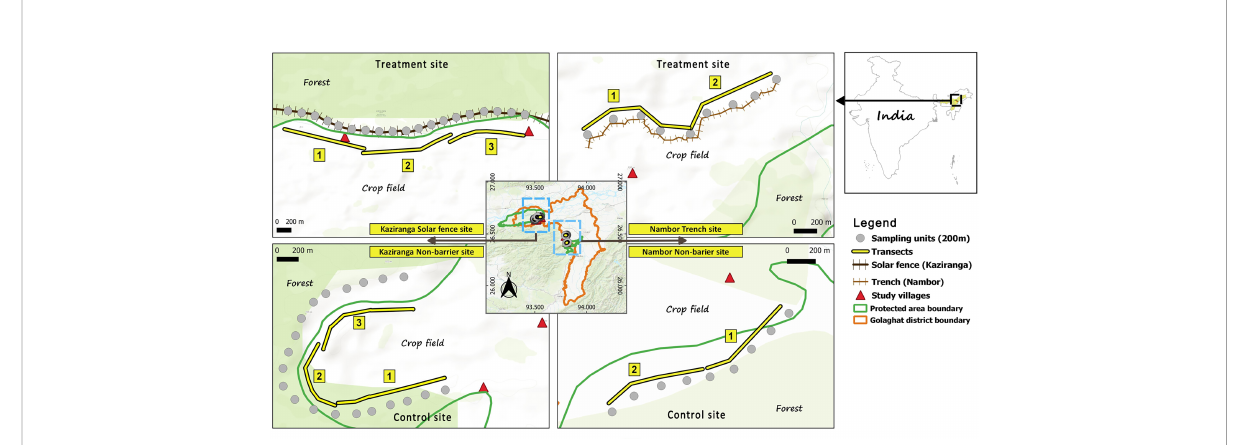
FIGURE 2 The study villages with transect layouts for elephant sign surveys along the barrier (treatment) and non-barrier (control) sites of Kaziranga National Park and Nambor Doigurung Wildlife